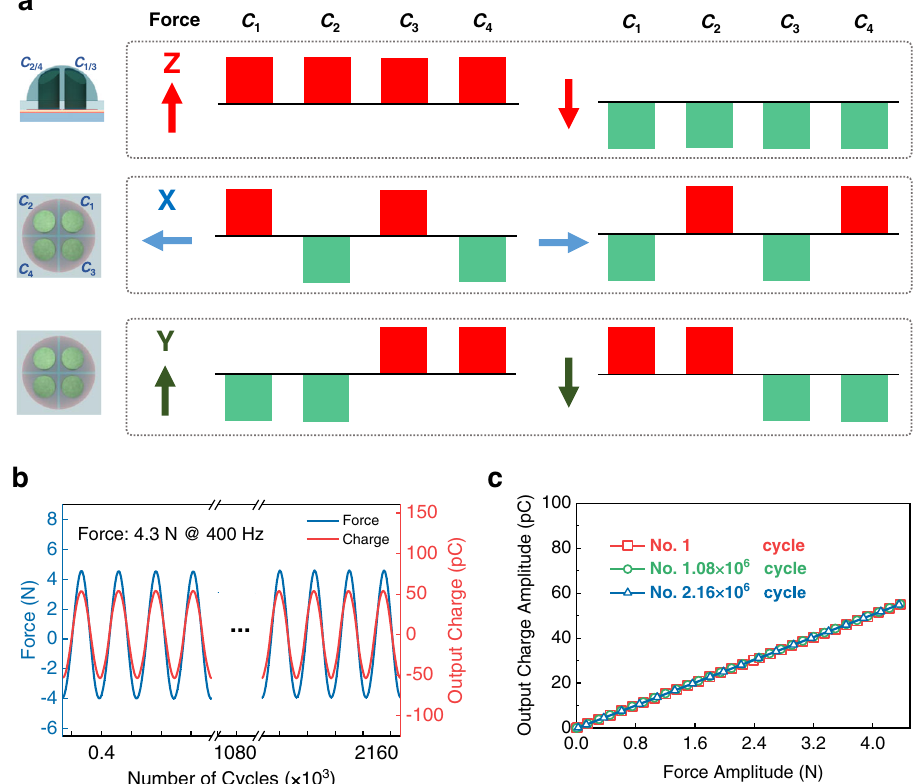
Fig. 3 | Force direction detection, cycling stability, and repeat performance of theRSHTS.a Forcedirection detection by one sensoryunit. b Signalstability over 2.16×10 6 cycles under a sinusoidal force of 4.3N and 400Hz. c Output charge of